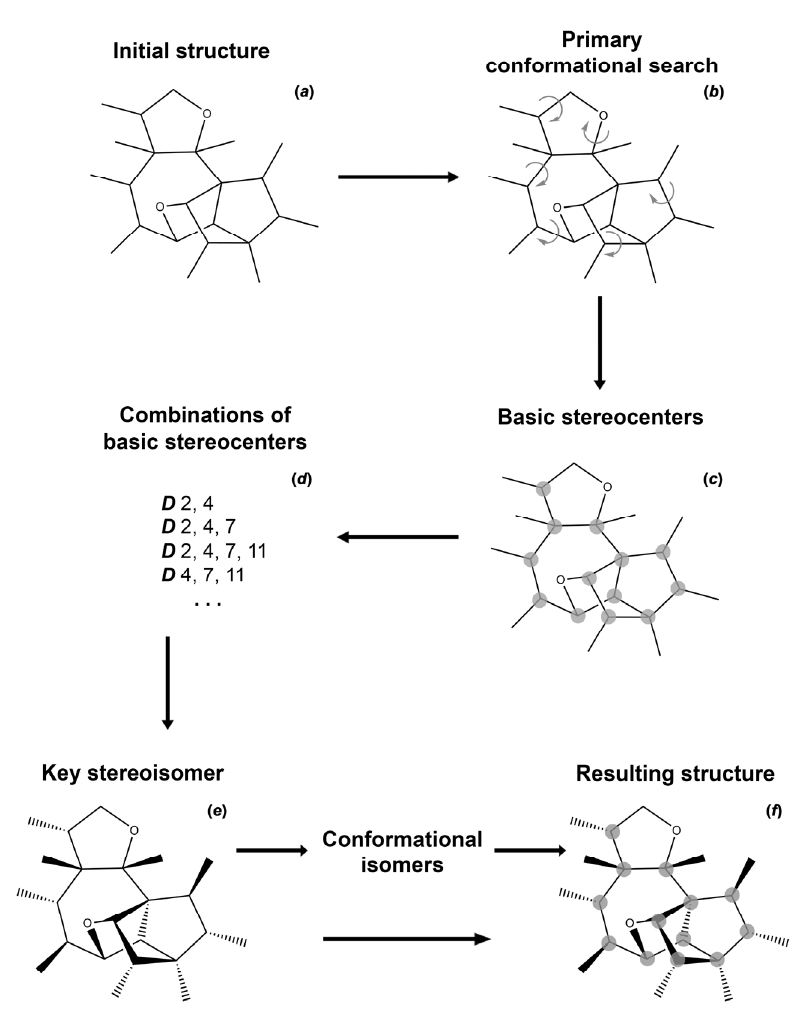
Scheme 1. A general workflow for the establishing of stereochemical structure of natural